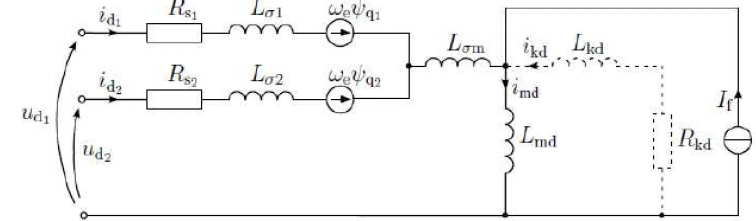
Figure 11. The equivalent model in d-q scheme of a double-star synchronous generator.